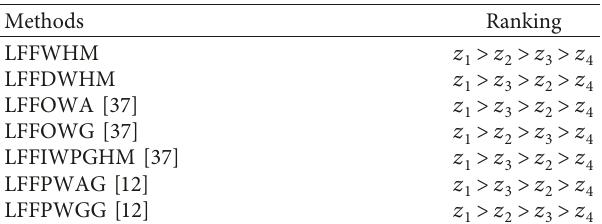
Table 21: Ranking results by different methods with the COPRAS method.